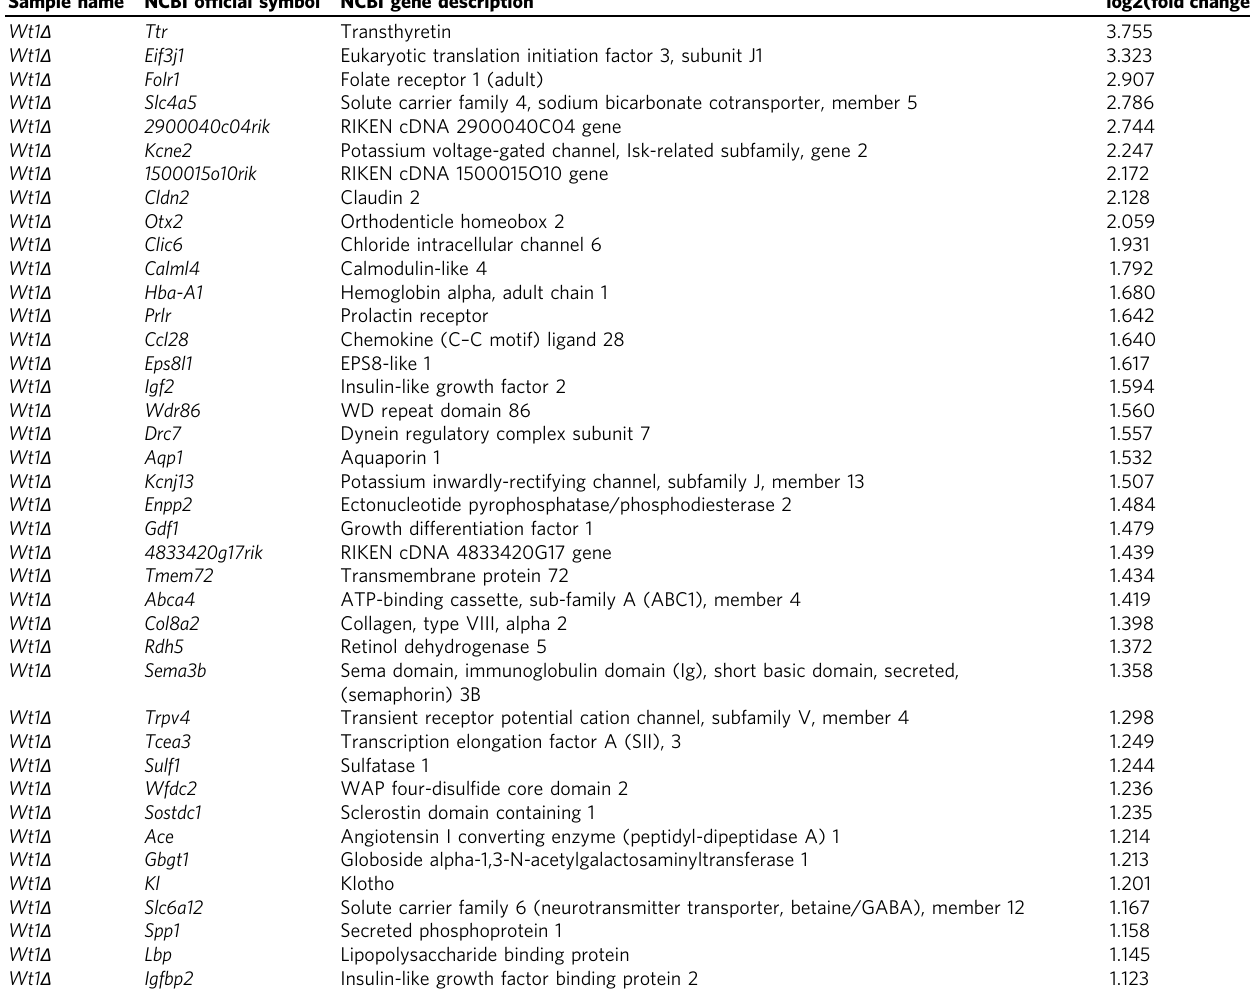
Table 1 Top 40 differentially expressed genes whose mRNA expression was regulated in the Wt1 Δ mice. Numbers indicate the log 2 -fold change for each gene comparing Wt1 Δ mice with wild type littermates. For the list of all differentially expressed genes, their gene symbols as well as their extended names see Supplementary Data